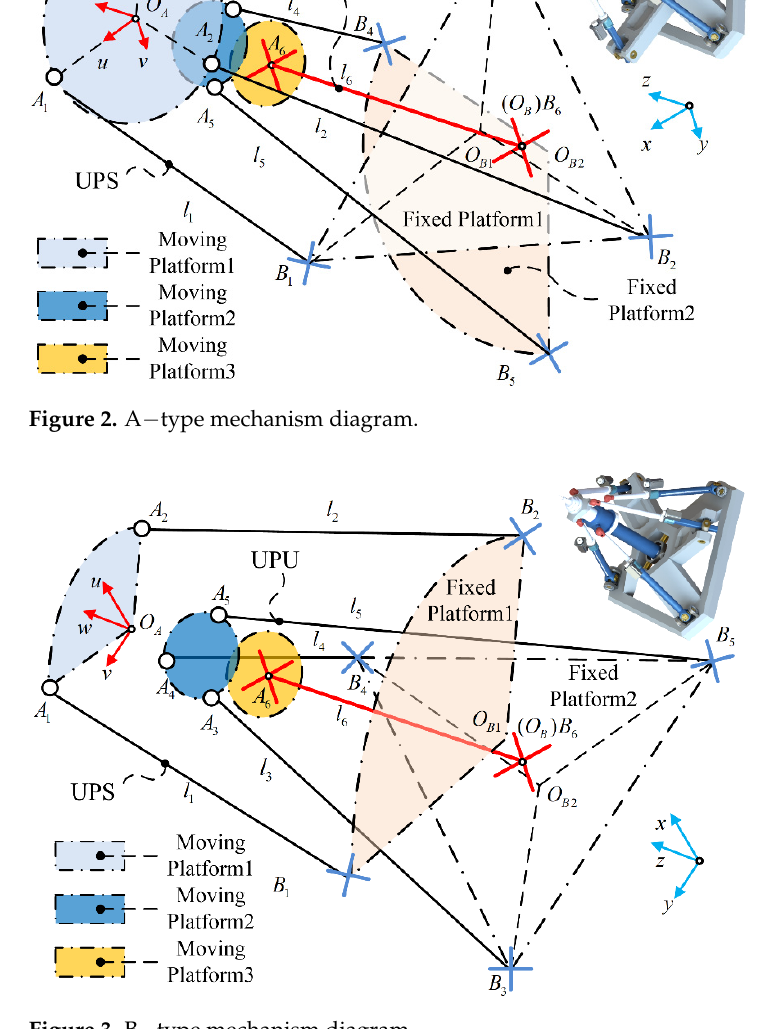
Figure 3. B − type mechanism diagram.